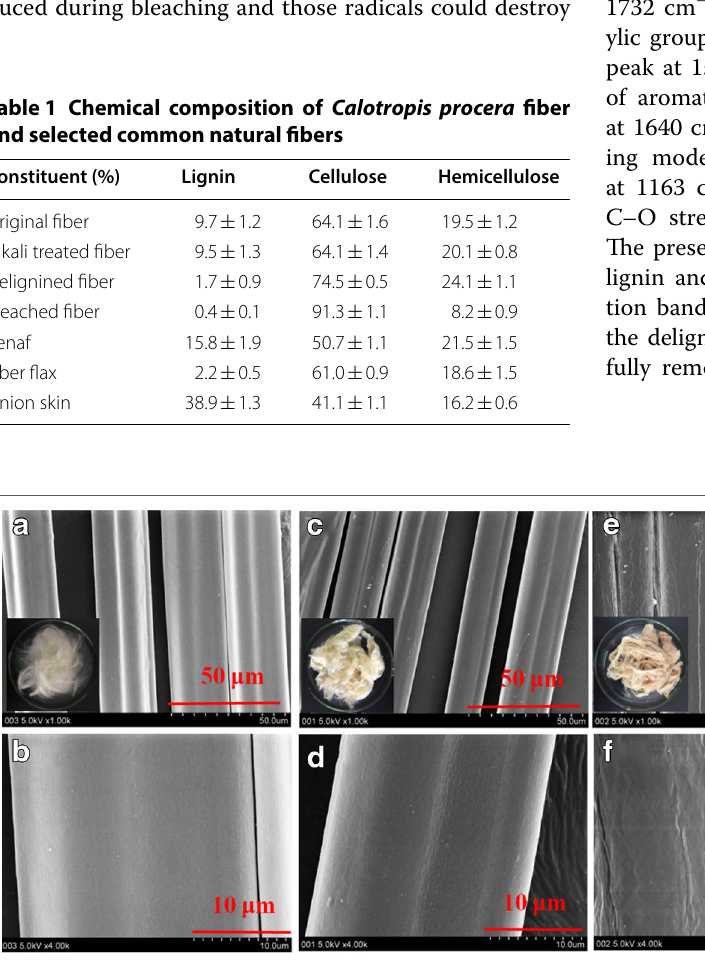
Fig. 2 Morphology of a , b the Calotropis procera fiber; c , d dewaxed Calotropis procera fiber; e , f Calotropis procera fiber after the delignification; g , h Calotropis procera fiber after